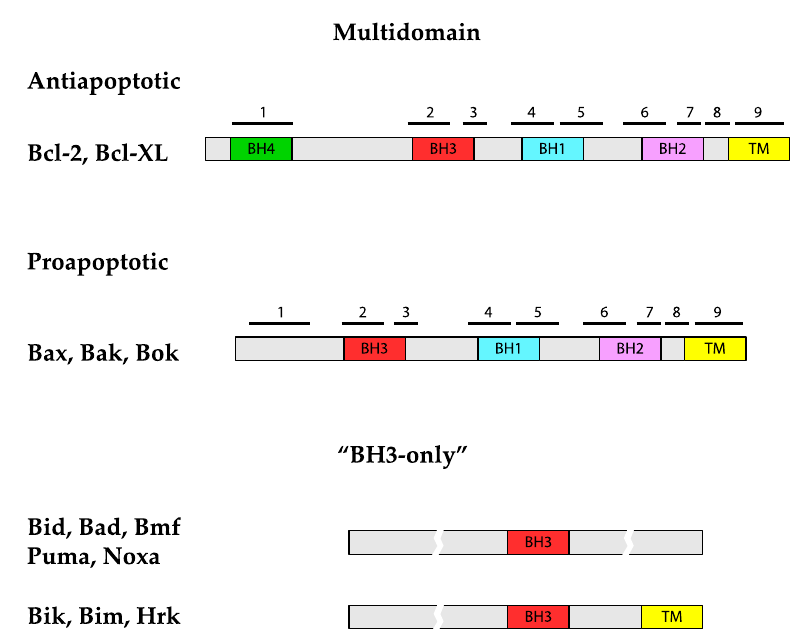
Figure 2. TheBcl-2familyofproteins. DomainstructureofBcl-2familyproteinsispresentedschematically. SizesofproteinsanddomainsareroughlyinscaleandpositionofBHdomainsisindicated. Inmultidomain Figure 2. The Bcl-2 family of proteins. Domain structure of Bcl-2 family proteins is presented proteins, positions of α -helices are indicated with numbered black schematically. Sizes of proteins and domains are roughly in scale and position of BH domains is indicated. In multidomain proteins, positions of α -helices are indicated with numbered black bars.